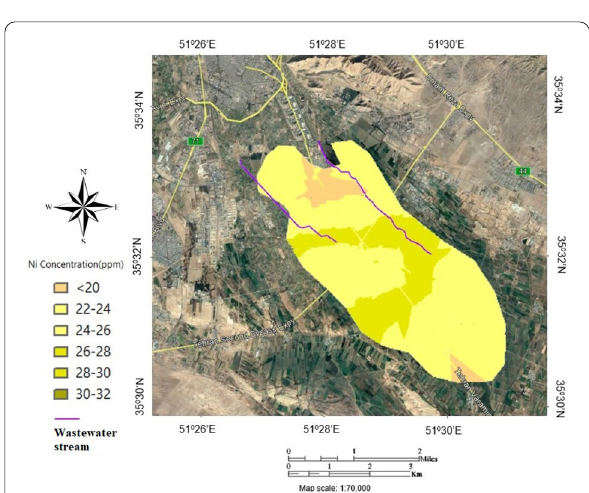
Fig. 4 Distribution heavy metal nickel in south